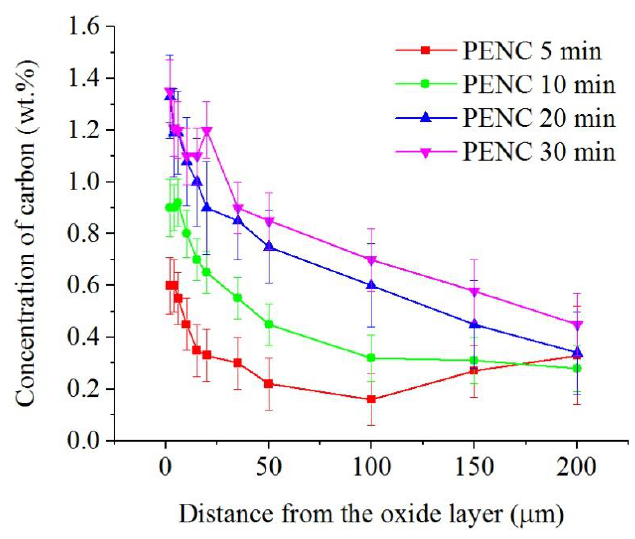
Figure 6. EDX carbon distributions in the nitrocarburized layer after cathodic PENC.